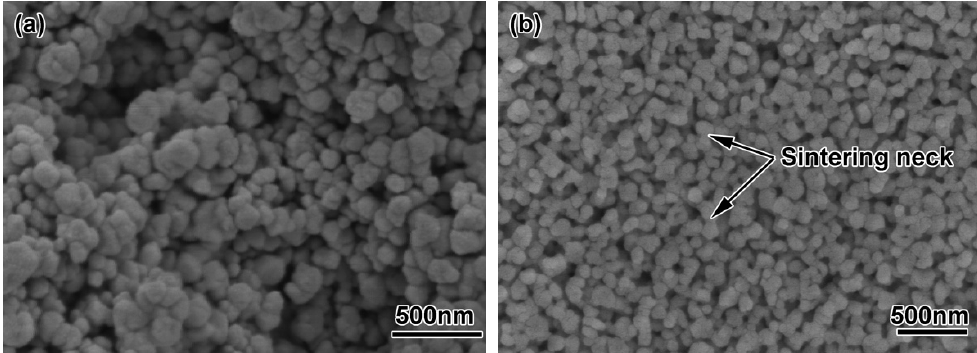
Figure 6. SEM morphology of debound ZrO 2 samples using different powders: ( a ) 200 nm; ( b ) 100 nm. Table 3. Flexural strength and linear shrinkage of the different samples after molding and debinding.